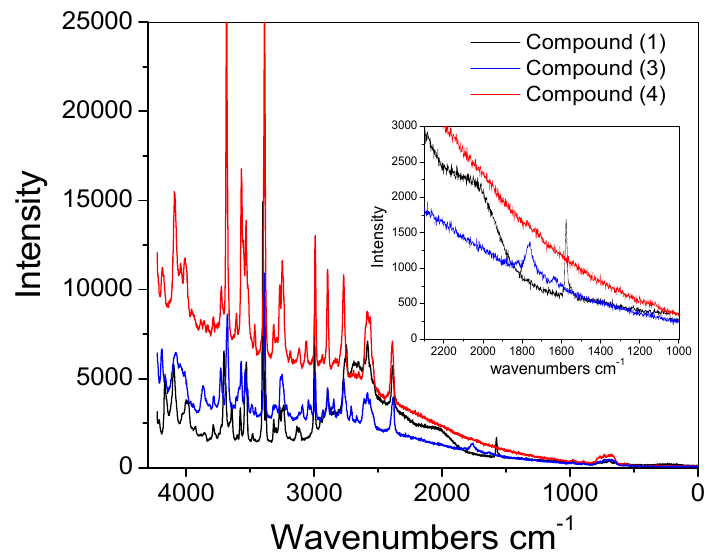
Figure 2. Raman spectra of compounds ( 1 ), ( 3 ), and ( 4 ) in solid state. The insert shows the C=N stretching band.